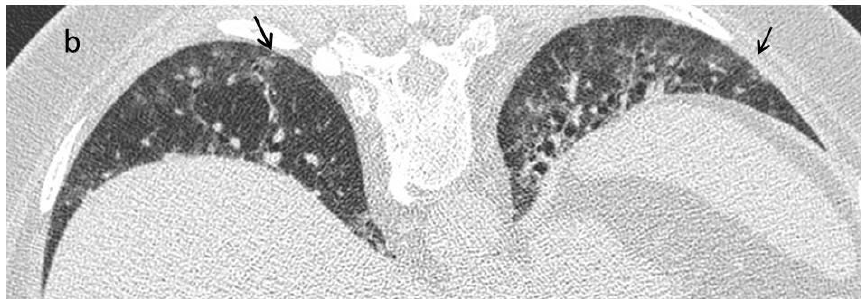
Figure 2. Early stage. A 42-year-old female with a diagnosis of SSc. ( a ) Axial High Resolution CT image shows subtle ground glass opacities (black arrows) in the peripheral areas of lung bases. An additional scan with patient in prone position can be helpful to differentiate gravity-related interstitial alterations from disease-related alterations. ( b ) The persistence of ground-glass opacities in the prone position is related to a nonspecific interstitial pneumonia (NSIP) pattern.